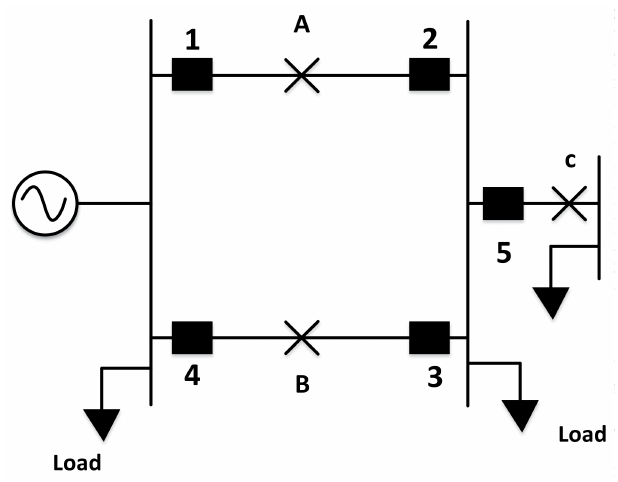
Figure 9. A single end parallel feeder distribution